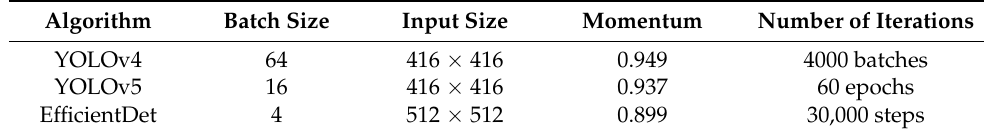
Table 2. Training parameters for each object detection algorithm used in this work.